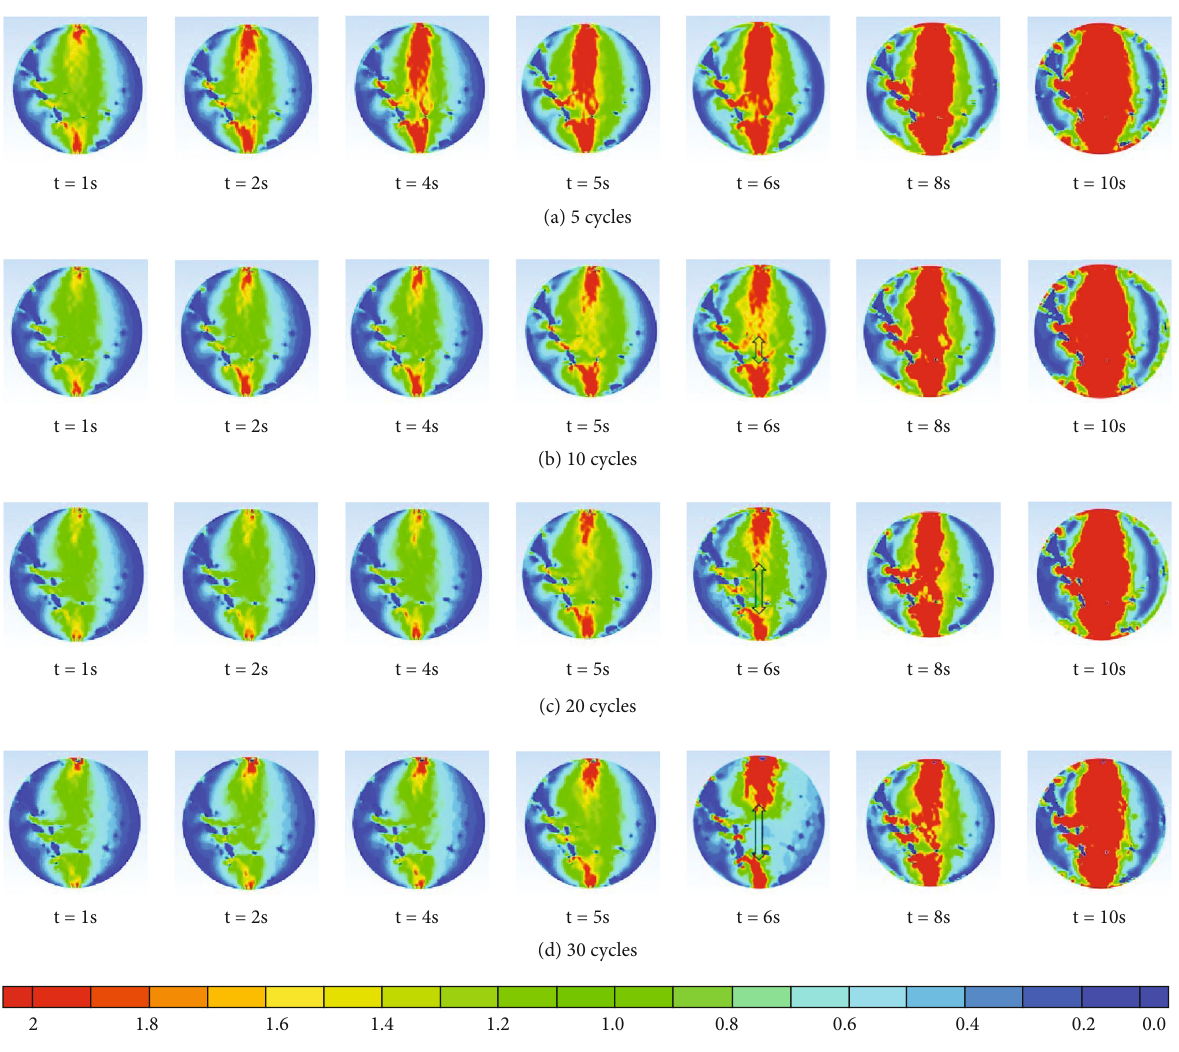
Figure 11: RFD evolution cloud image of sandstone under di ff erent freezing-thawing